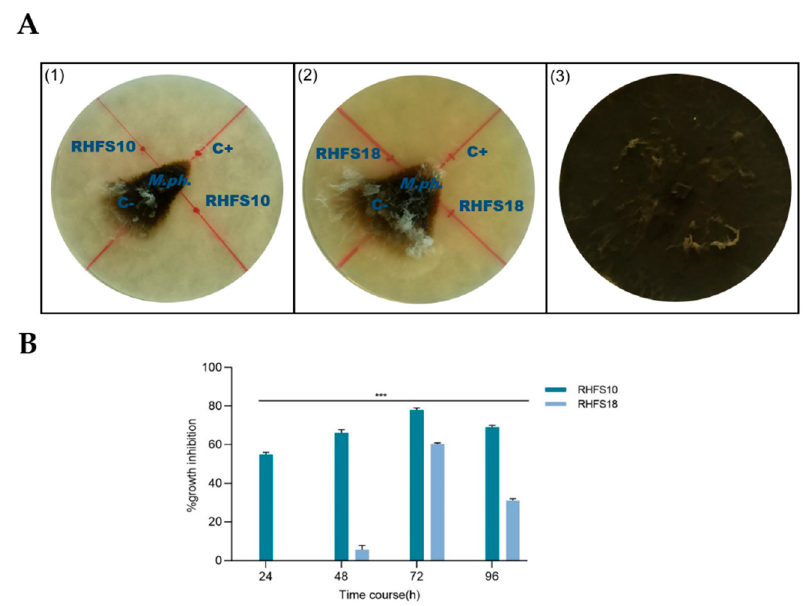
Figure 3. Antifungal activity of secreted metabolites by Plant Growth-Promoting Rhizobacteria (PGPR) strains. ( A ) Effects of the CSFs from RHFS10 (panel 1) and RHFS18 (panel 2) strains collected after 72 h of growth on the mycelial growth of M. phaseolina (panel 1). C+: Positive control, pentachloronitrobenzene; C − : Negative control, toluene. All experiments were performed in triplicate with three independent trials. ( B ) Antifungal activity of the Cell-Free Supernatants (CFSs) of the two strains RHFS10 and RHFS18 collected from 24 to 96 h of growth. Percentage of fungal growth inhibition was reported as the percentage reduction in the diameter of the fungal mycelia compared to control plate (panel 3). Data are presented as means ± standard deviation ( n = 3). For comparative analysis of groups of data, one-way ANOVA was used and p values are presented in the figure: ***: extremely significant < 0.001.